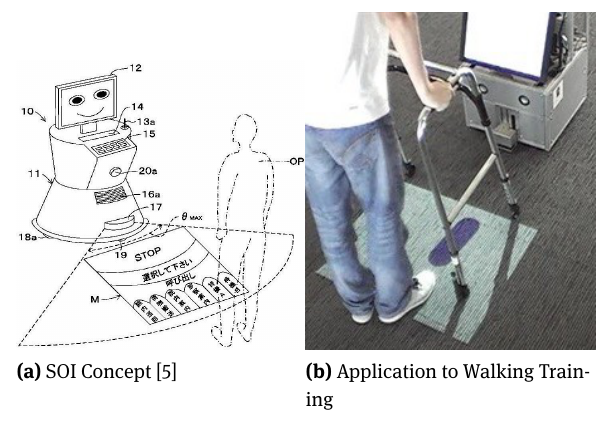
Fig. 1. Step-on Interface (SOI).